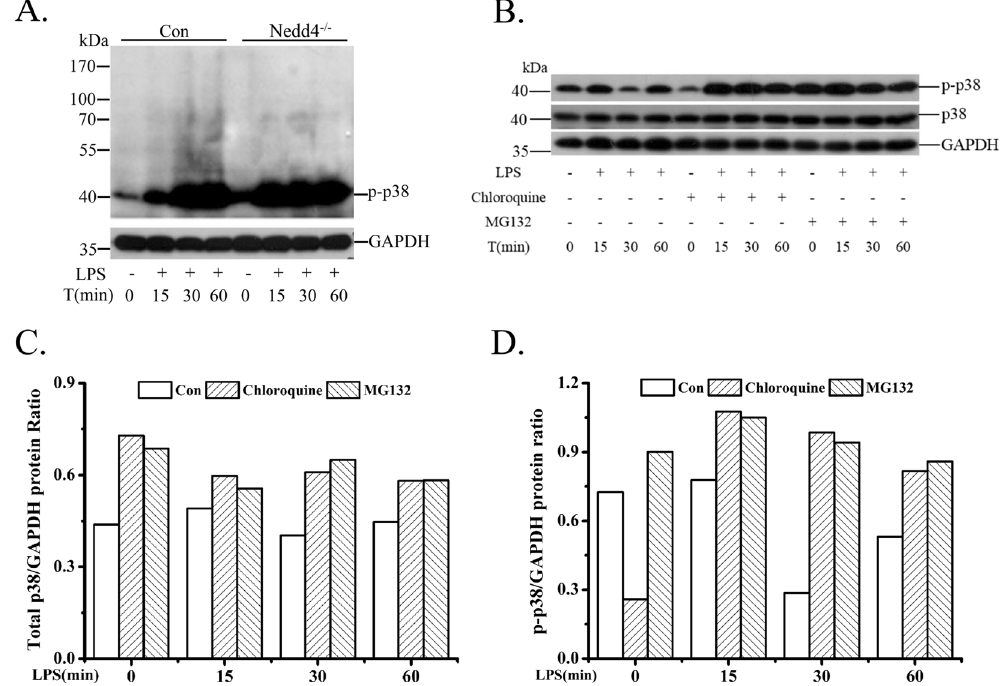
Figure 2. p38, especially p-p38 α might be involved in Nedd4 ubiquitination system. ( A ) The smear bands above 40 kDa almost disappeared in Nedd4 − / − iBMDM cells. Overexposure for immunoblot analysis of p-p38